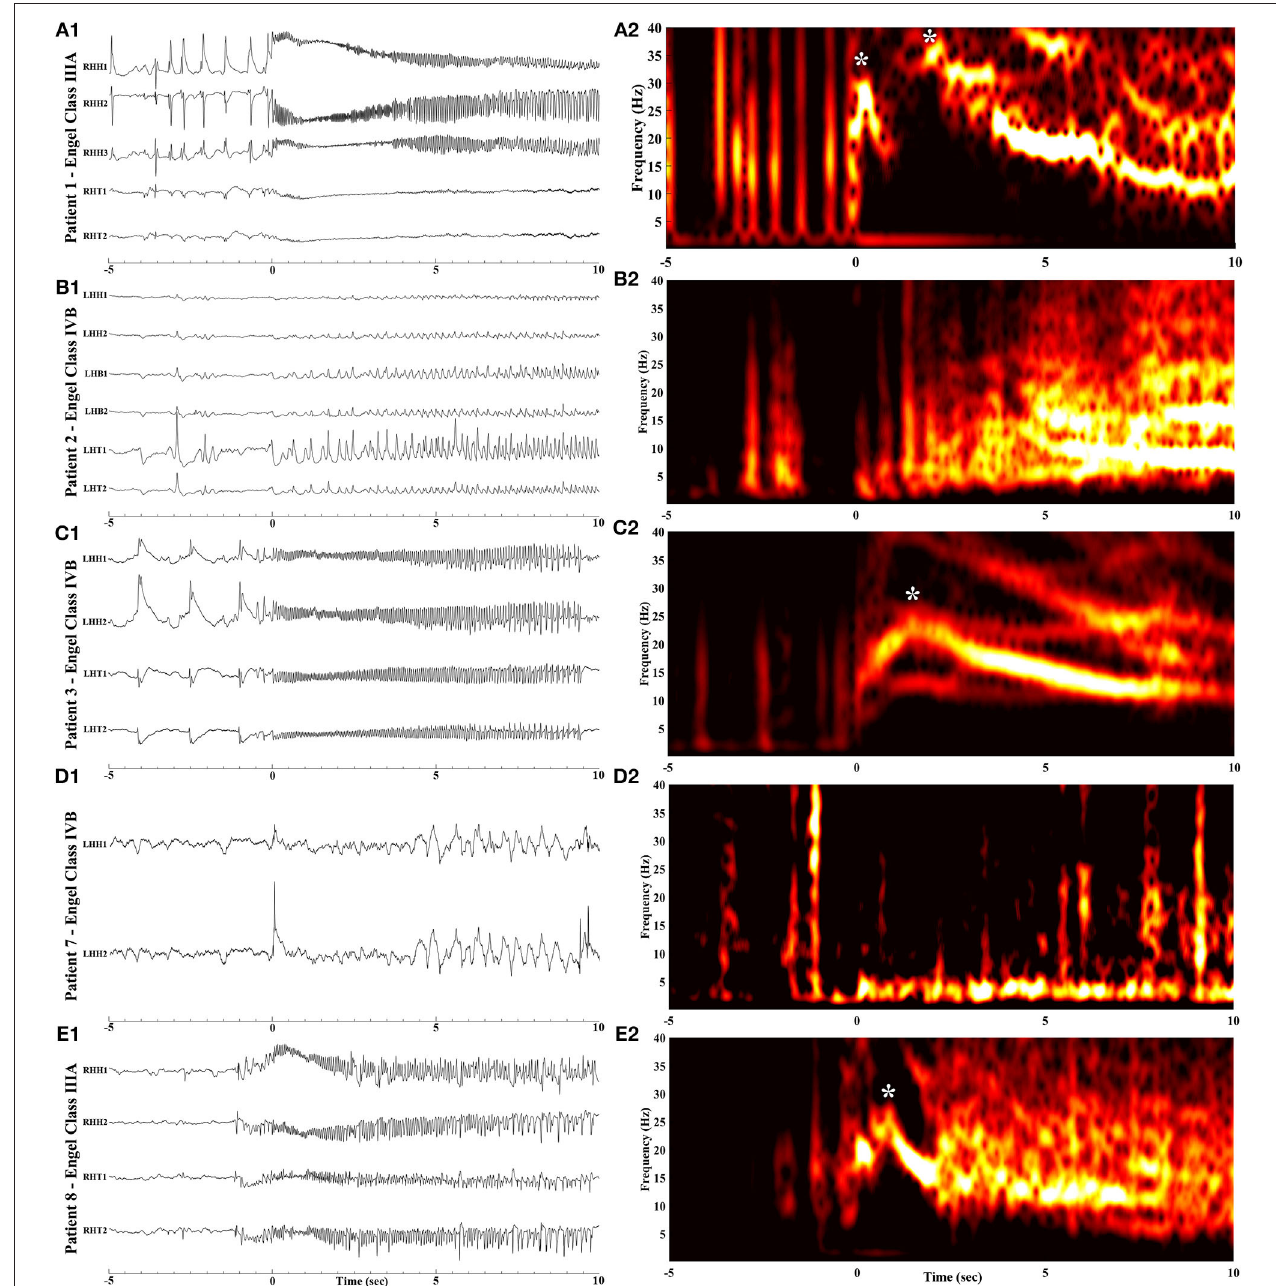
FIGURE 3 | Raw iEEG (left, A 1 -E 1 ) from the MT contacts and respective time-frequency analysis (right, A 2 -E 2 ) of seizure onsets in patients with poor outcome. (A 1 ,A 2 ) Patient 1 with Engel Class IIIA outcome. (B 1 ,B 2 ) Patient 2 with Engel Class IVB outcome. (C 1 ,C 2 ) Patient 3 with Engel Class IVB outcome. (D 1 ,D 2 ) Patient 7 with Engel Class IVB outcome. (E 1 ,E 2 ) Patient 8 with Engel Class IIIA outcome. Notice the rise in frequency content with a peak indicated by asterisks, following ictal onset (at time =